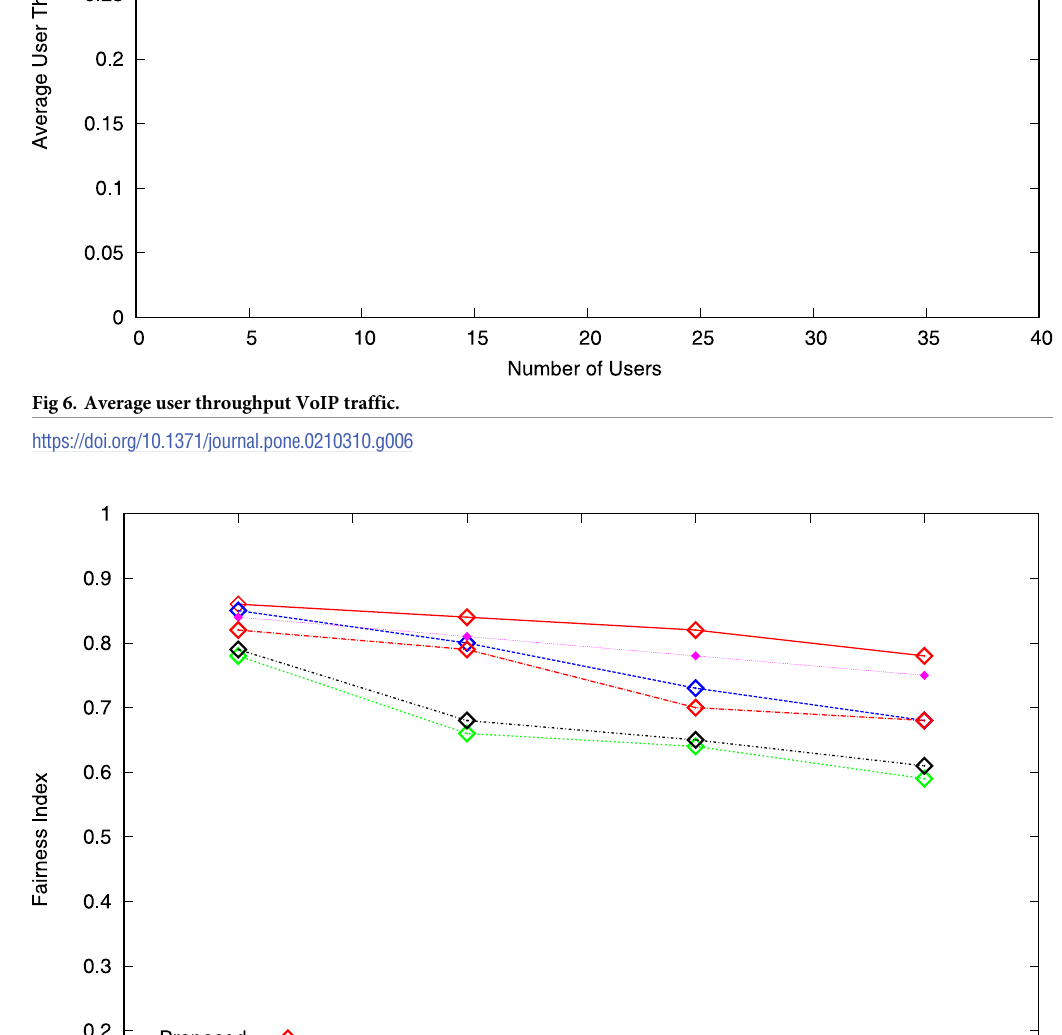
Fig 7. Fairness index video